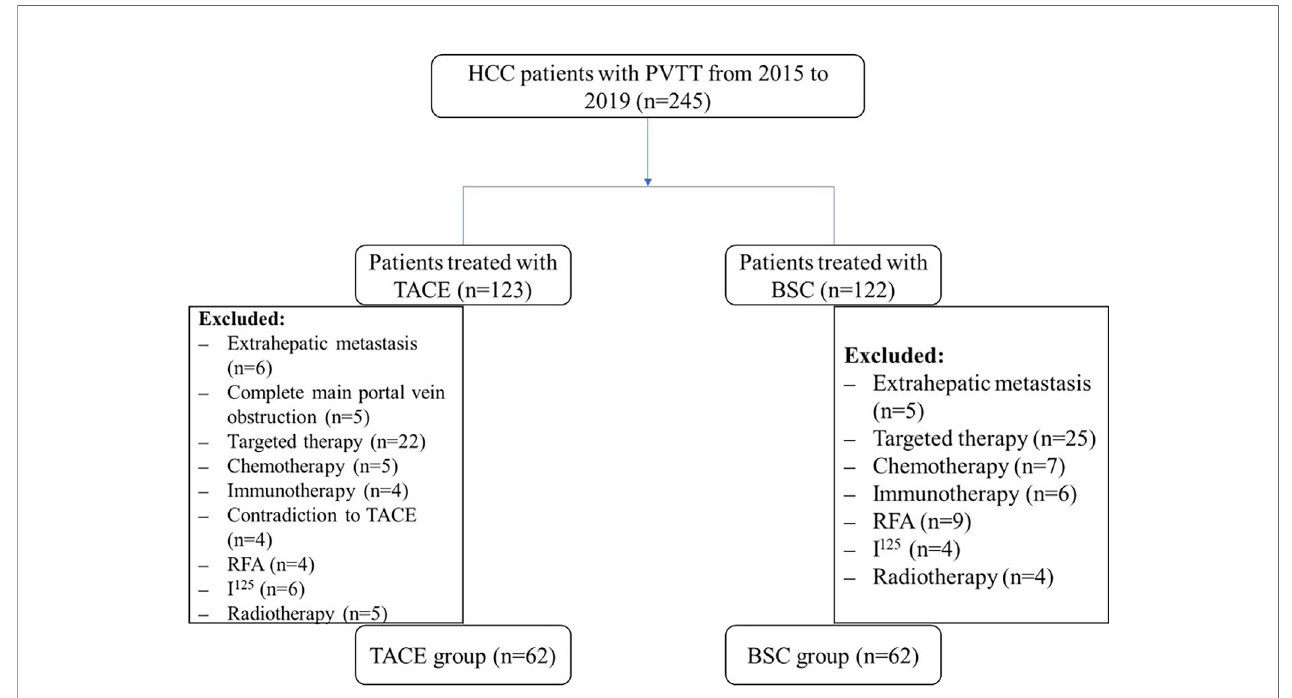
FIGURE 1 | Flowchart of elderly HCC patients with PVTT